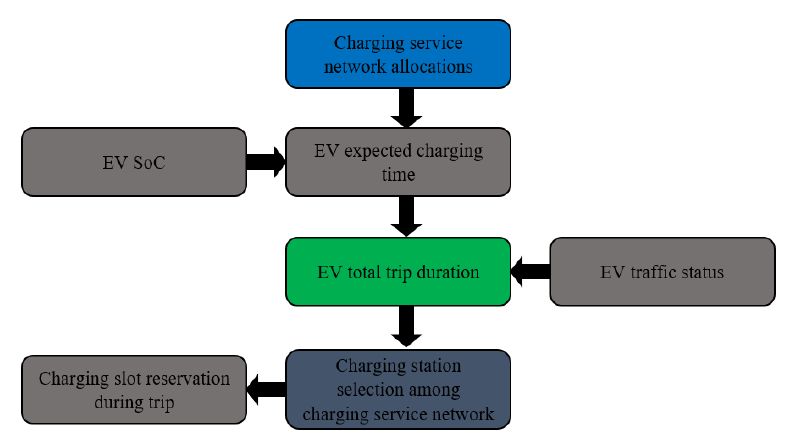
Figure 5. Overview of electric vehicle charging management network.